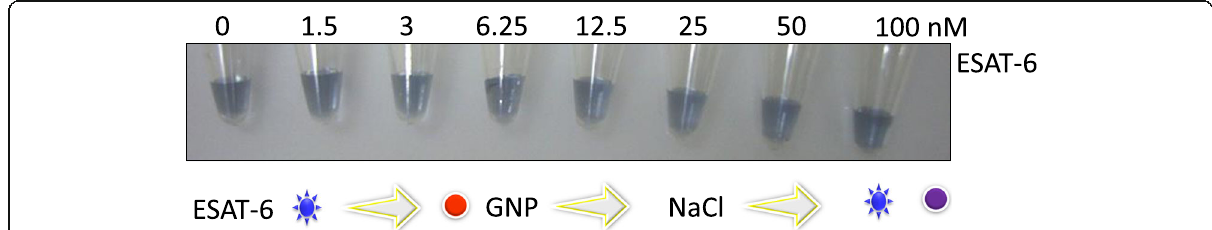
Fig. 4 Test for ESAT-6 fouling on GNP surface. Different concentrations of ESAT-6 were mixed with GNP, and after 30 min, 800 mM of NaCl was added. Diagrammatic representation is also shown. The appearance of a blue color indicates the aggregation